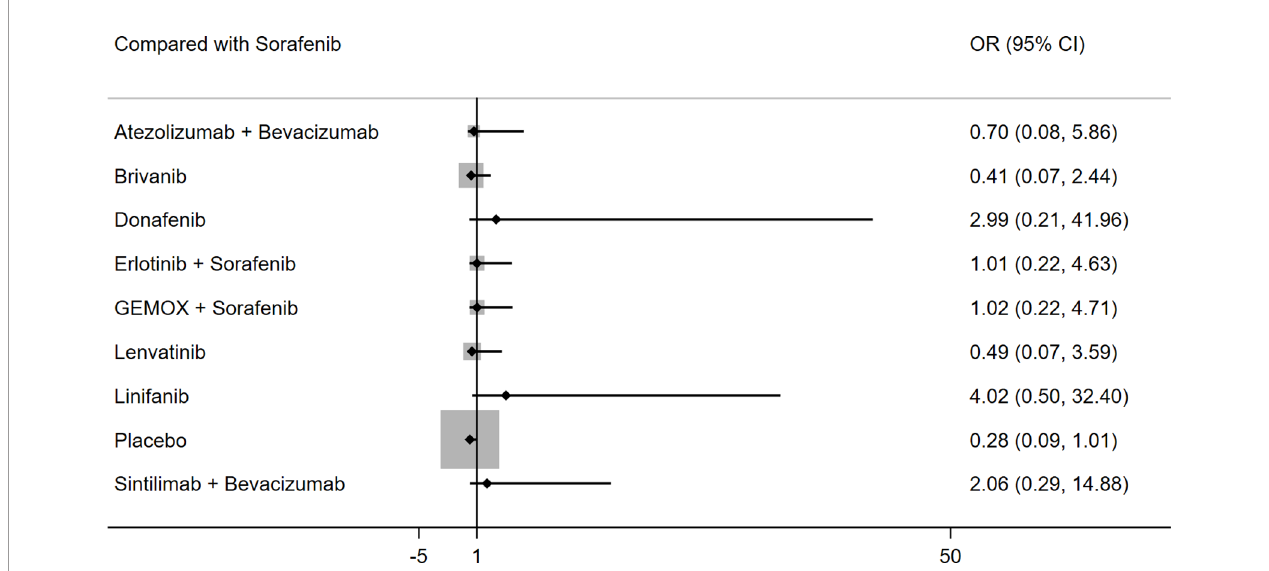
FIGURE 4 | Forest plot for OR of any grade